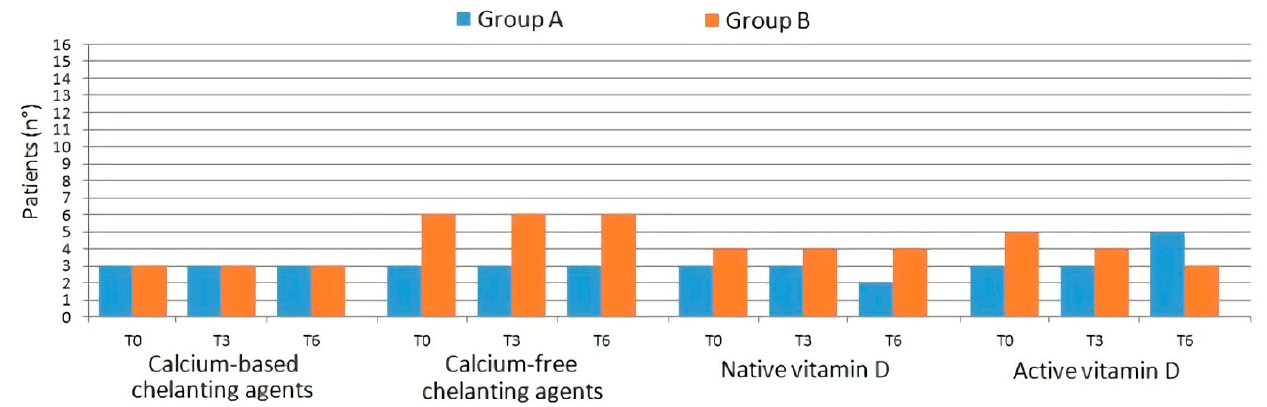
Figure 2. Changes in concomitant therapies with chelating agents and vitamin D in the two groups.